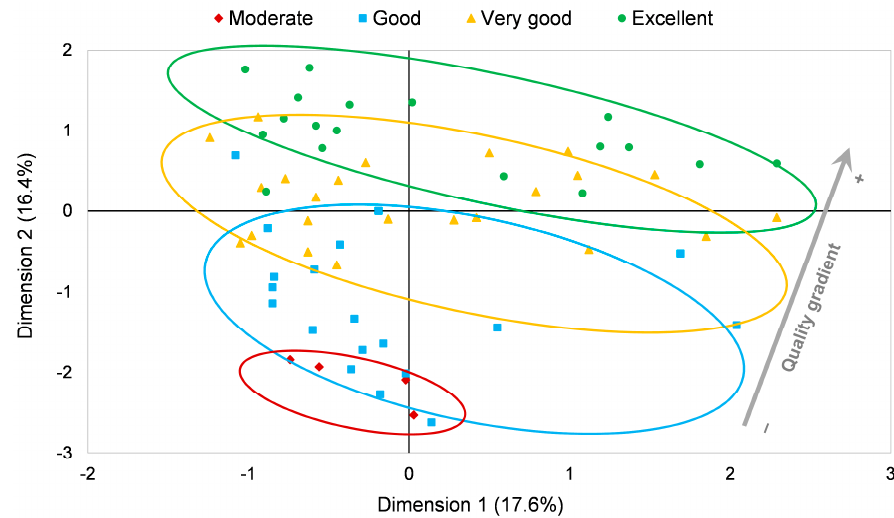
Figure 2. Quality gradient observed in the distribution of the “Chorizo Zamorano” samples in the first bi-dimensional plane.